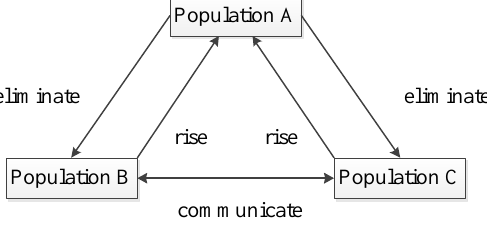
Figure 8. Migration process.